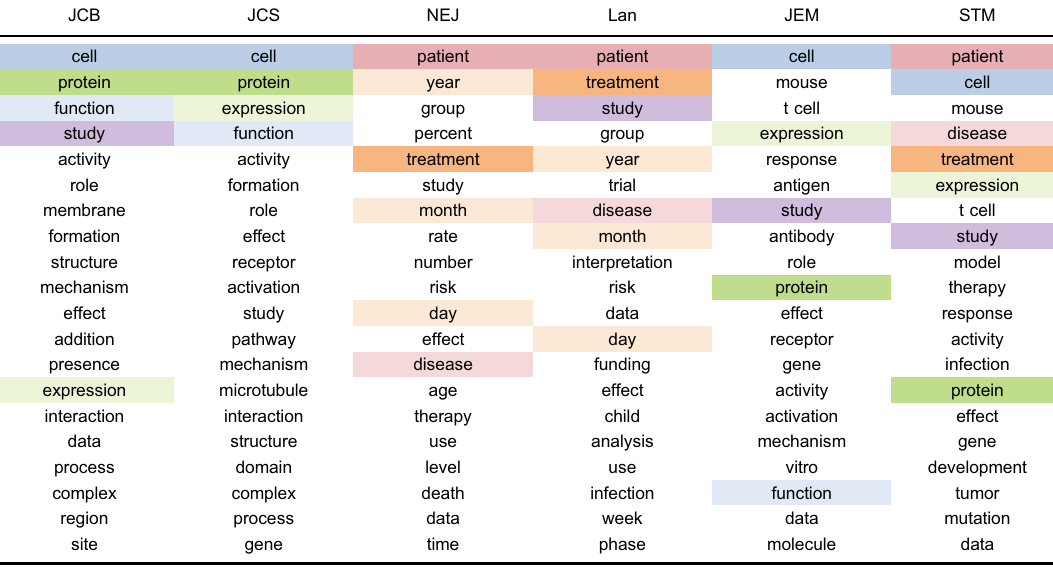
Table 1. Comparison of the most frequent words in titles and abstracts of articles in cell biology, medicine, and translational research journals.